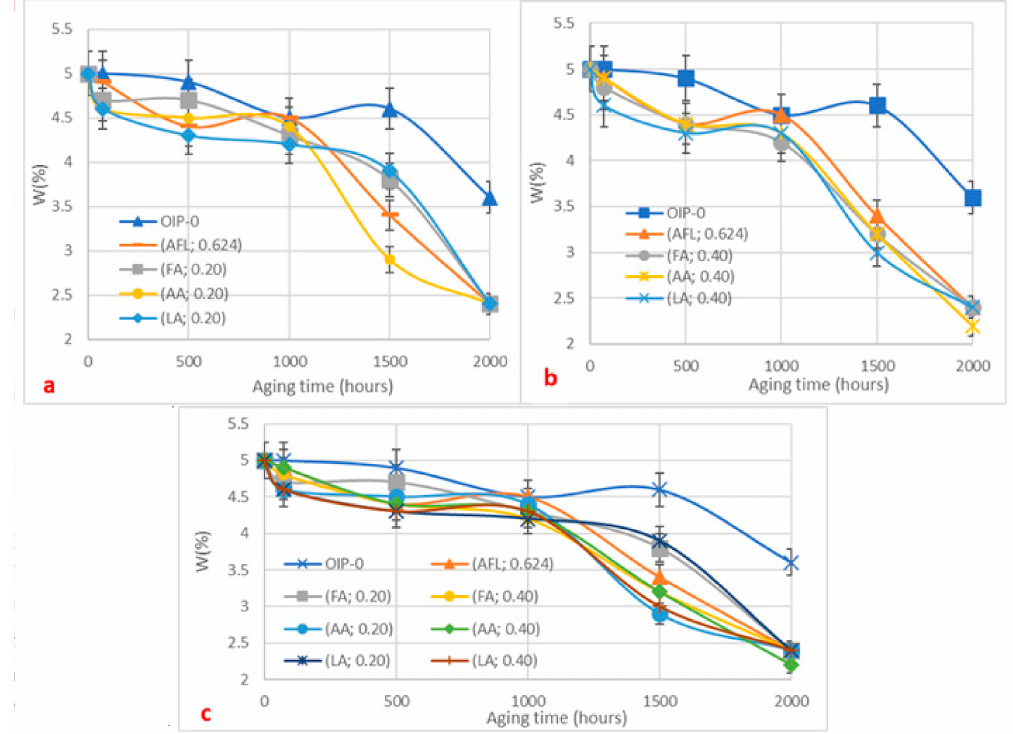
Figure 1. Moisture in paper as function of oil aging time within both acid contents: ( a ) 0.20 mg KOH/g and ( b ) 0.40 mg KOH/g for three different acids (formic, acetic and levulinic), acid mixture and also for acid-free oil. The results are summarized in Figure ( c ) for better